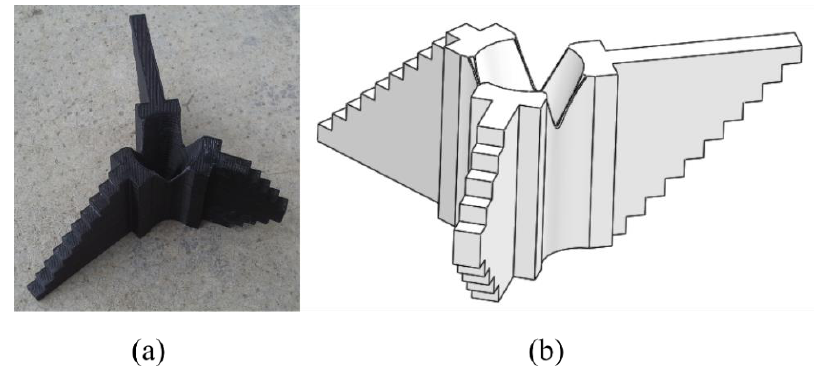
Figure 8. ( a ) 3D printed object; ( b ) Its CAD model.